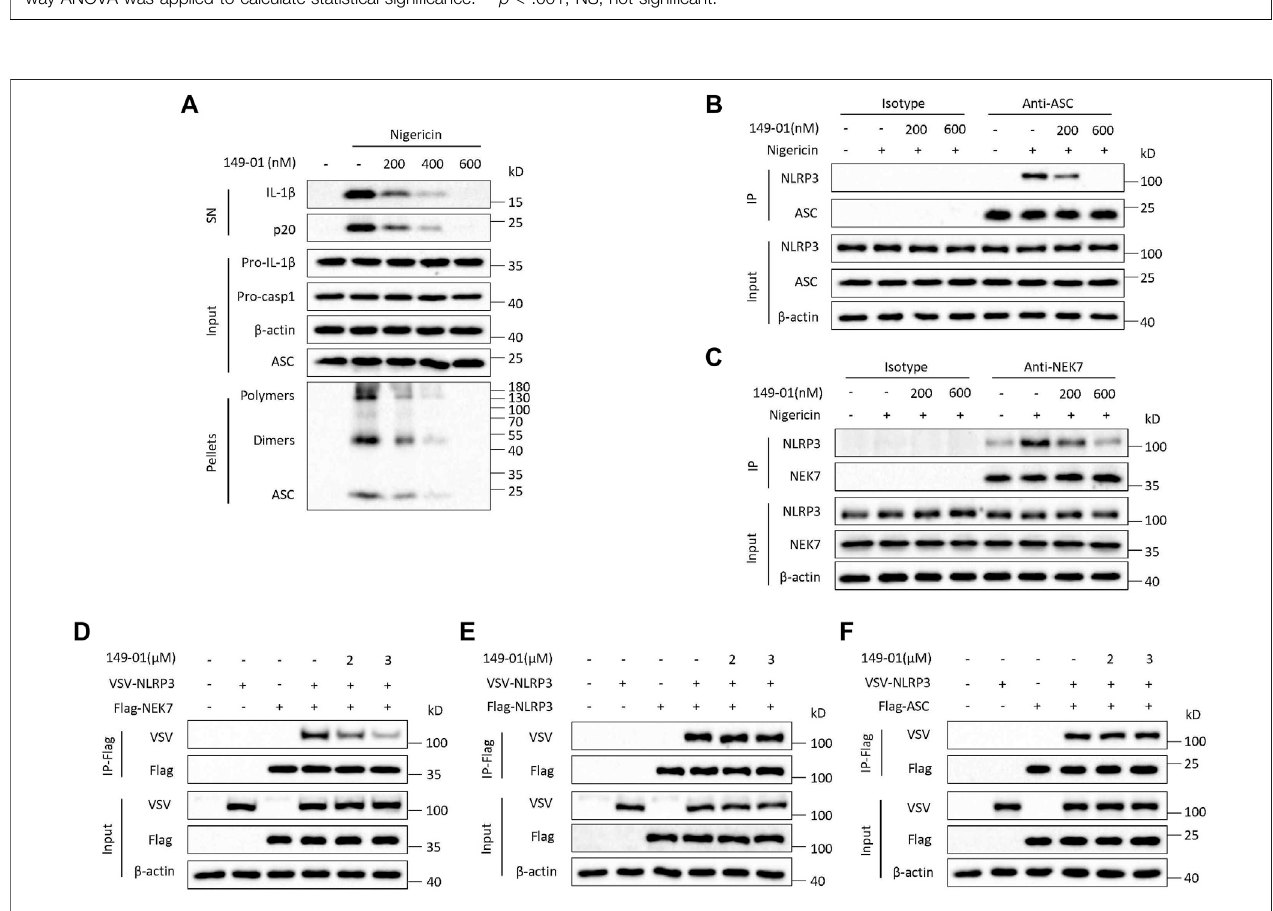
FIGURE 3 | 149-01 blocks the assembly of NLRP3 in fl ammasome by preventing the interaction between NEK7 and NLRP3. (A) Supernatants, cell lysates and DSS-crosslinked pelletsfromLPS-primedBMDMstreatedwithindicateddosesof149-01 for30 minbeforenigericinstimulationwereanalyzedbywesternblot. (B) The endogenous NLRP3-ASC interaction in LPS-primed BMDMs treated with indicated doses of 149-01 for 30 min before nigericin stimulation was detected by immunoprecipitation (IP) and western blot. (C) The endogenous NEK7-NLRP3 interaction in LPS-primed BMDMs treated with indicated doses of 149-01 for 30 min before nigericin stimulation was detected by IP and western blot. (D) The NEK7 – NLRP3 interaction in HEK-293T cells transfected with Flag-NEK7, VSV-NLRP3 plasmidsand treatedwithindicateddosesof149-01 wasevaluated byIPand westernblot. (E) TheNLRP3 – NLRP3 interaction in HEK-293T cellstransfectedwithFlag- NLRP3, VSV-NLRP3 plasmids and treated with indicated doses of 149-01 was evaluated by IP and western blot. (F) The NLRP3 – ASC interaction in HEK-293T cells transfected with Flag-ASC, VSV-NLRP3 plasmids and treated with indicated doses of 149-01 was evaluated by IP and western blot. Data are representative of three independent